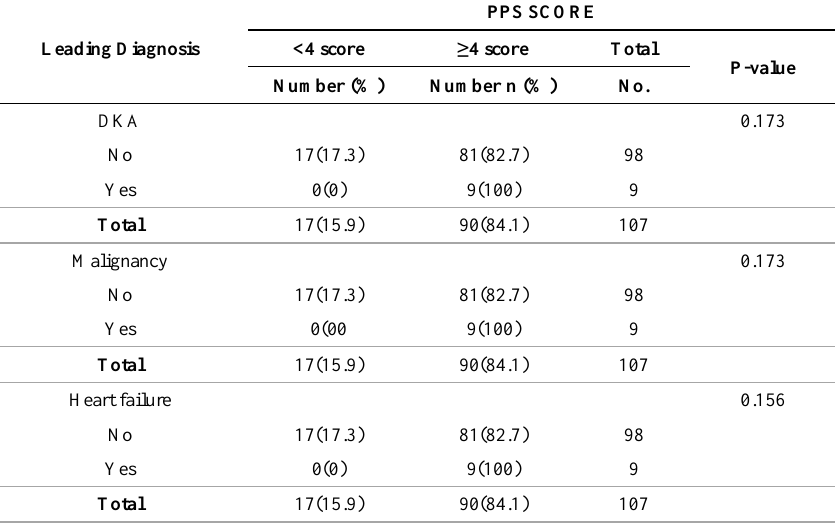
Table 4. Bivariate analysis of the leading diagnosis and Padua prediction